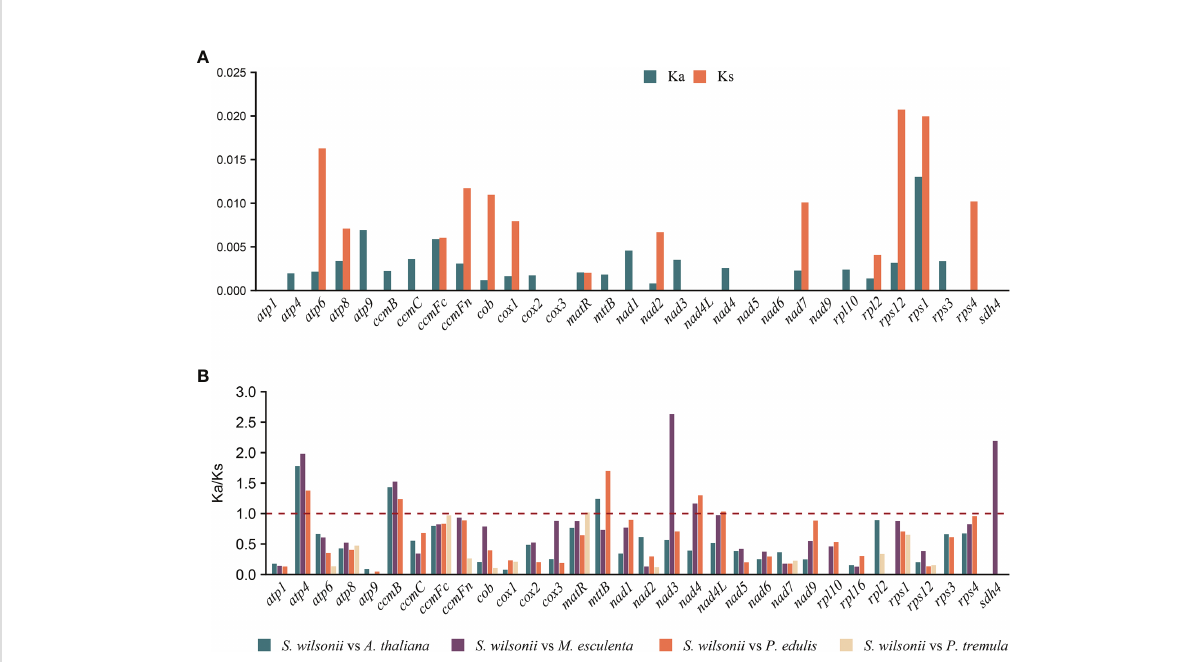
FIGURE 3 Nonsynonymous (Ka), synonymous (Ks), and Ka/Ks substitution values of S. wilsonii . (A) Values of Ka and Ks for P. tremula vs. S. wilsonii. (B) Ka/ Ks values of 24 PCGs of S. wilsonii versus four other